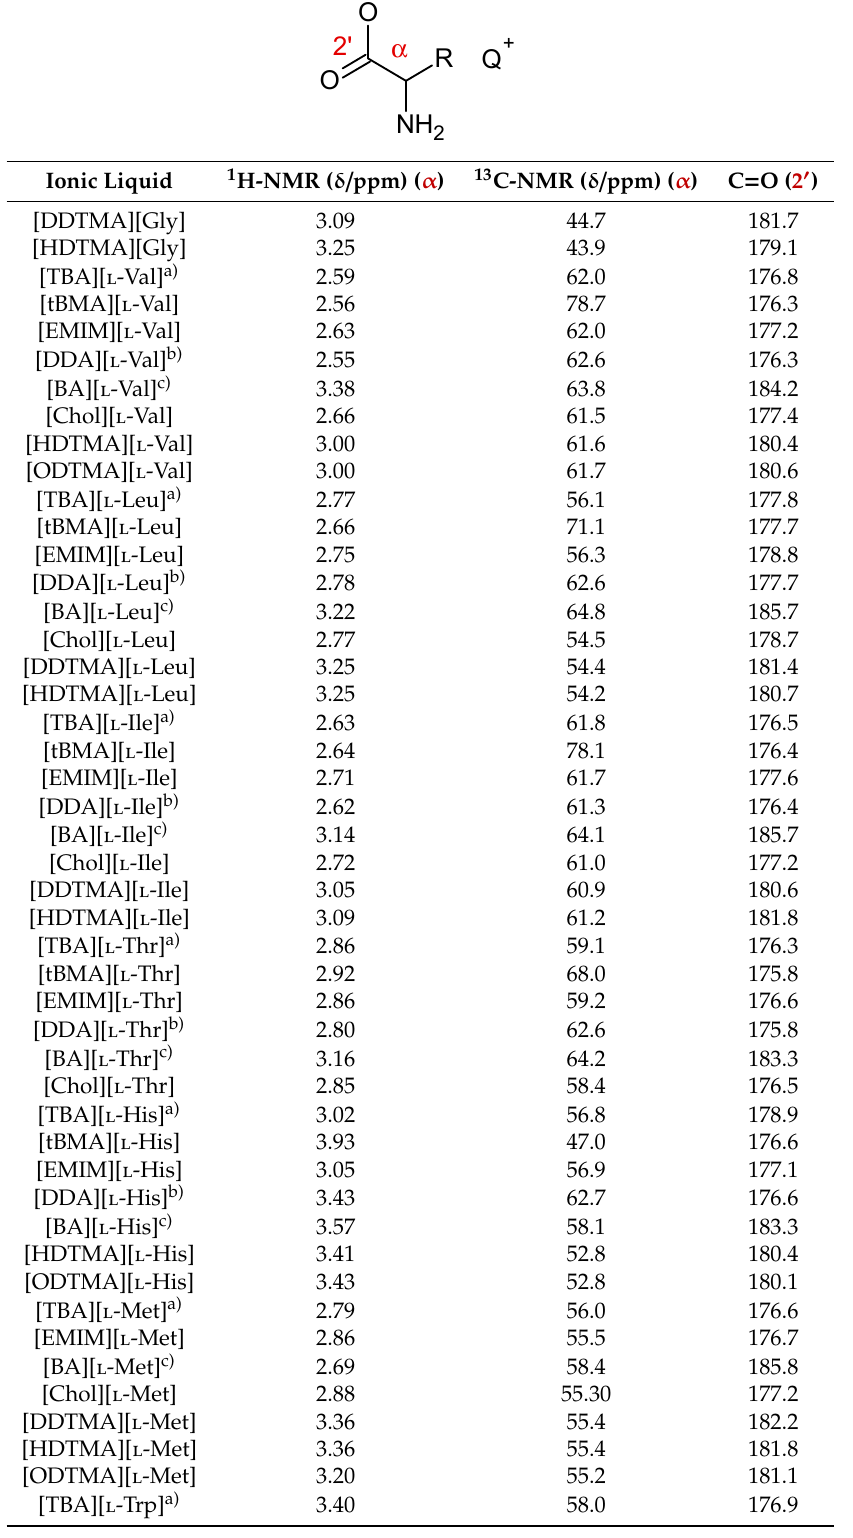
Table 1. 1 H-NMR and 13 C-NMR chemical shifts (relative to TMS) of α -positions (H-1 (cid:48) , C-1 (cid:48) ) and C = O of compounds studied in DMSO-d 6